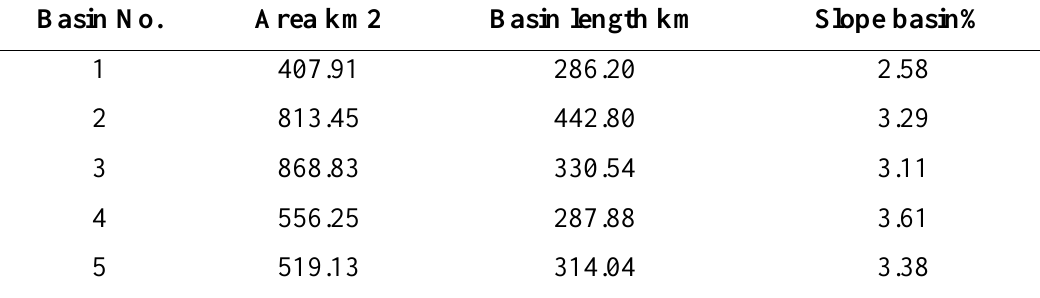
Table 5. The details of sub-basins of basin